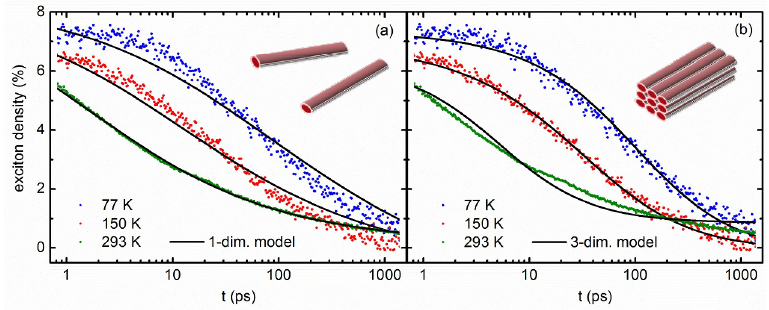
Fig. 2. Time dependent exciton densities as obtained from integrated transient absorption signals together with fits assuming (a) one-dimensional and (b) three-dimensional exciton